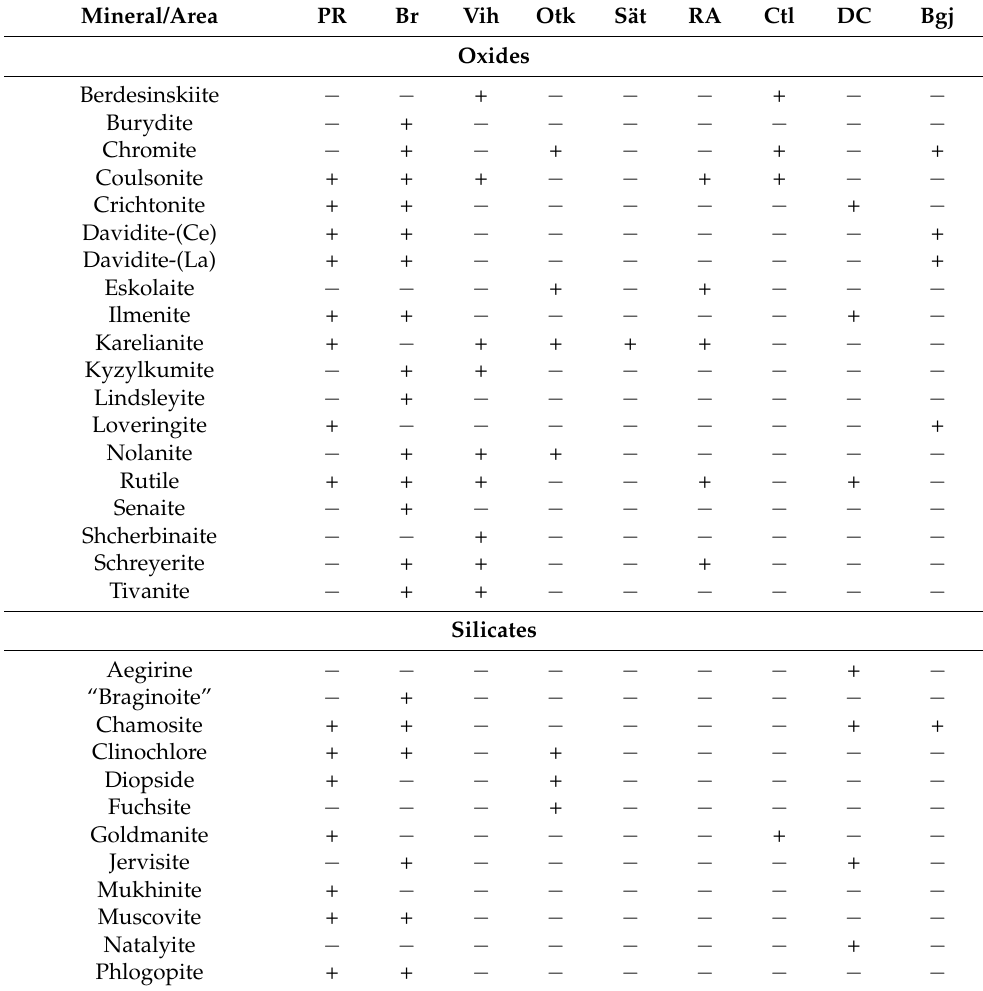
Figure 4. Vanadium mineralization in Pyrrhotite Ravine sulfide ore: karelianite ( a ) and coulsonite ( b ) with rim of vanadium silicates. Back-scattered electron (BSE) images. Cou, coulsonite; Kar, karelianite; Mukh, mukhinite; Po, pyrrhotite; V-mukh, vanadomukhinite. Mineral abbreviations hereafter on [44] apart from introduced by the authors for rare minerals. Table 1. Major V-Cr-Ti-Sc-bearing minerals in some sulfide ore deposits in the Kola Region and throughout the world.